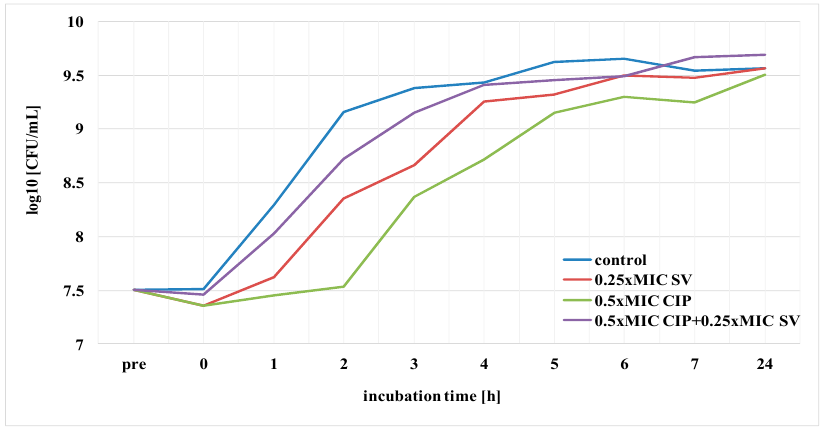
Figure 6. PASME of ciprofloxacin (CIP) against E. coli in the presence of S. virgaurea extract (SV).